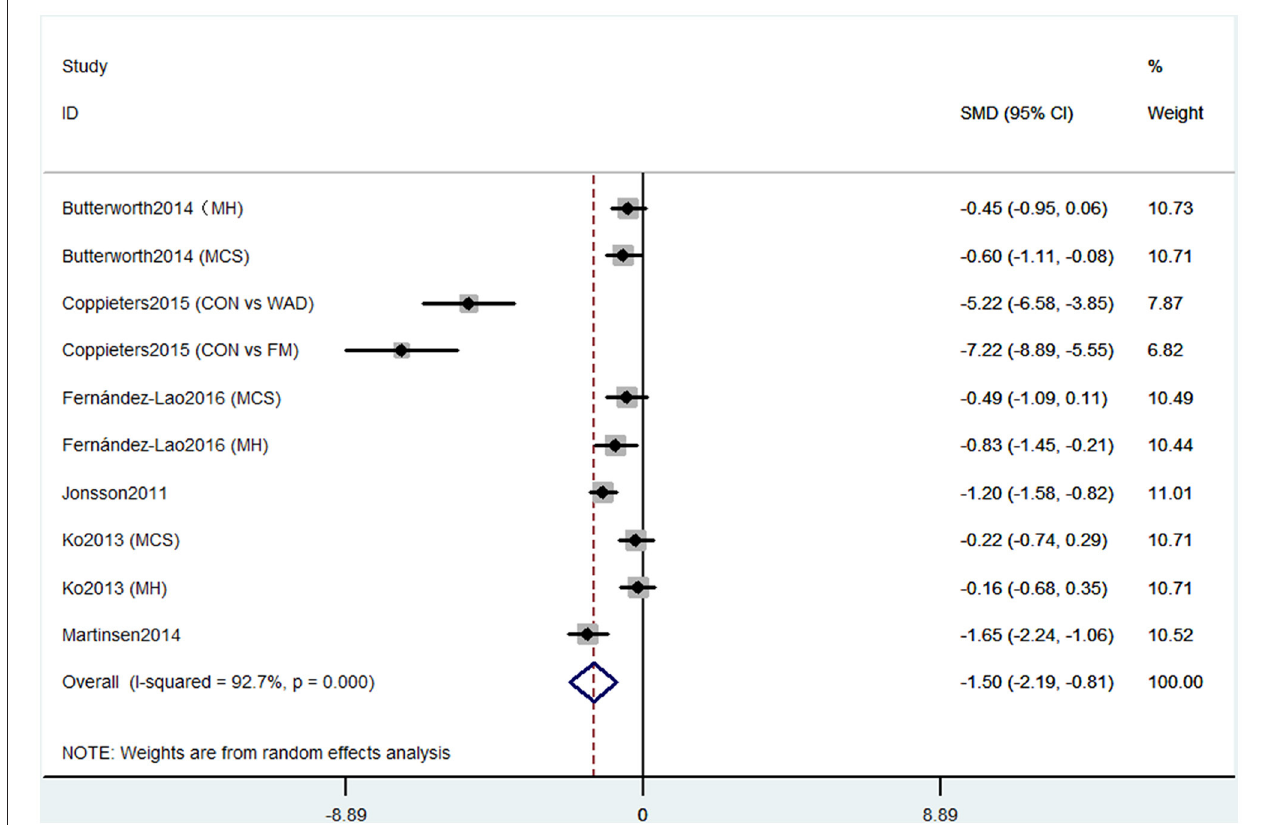
FIGURE 2 | Forest plot of the SMD and 95% CI from a random-effects meta-analysis for the association between chronic pain and incidence of cognitive decline when SF-36 mental component summary was used. MH, mental health score of SF-36; MCS, mental component summary score of sf-36; CON, control group; WAD, whiplash-associated disorder group; FM, fibromyalgia syndrome